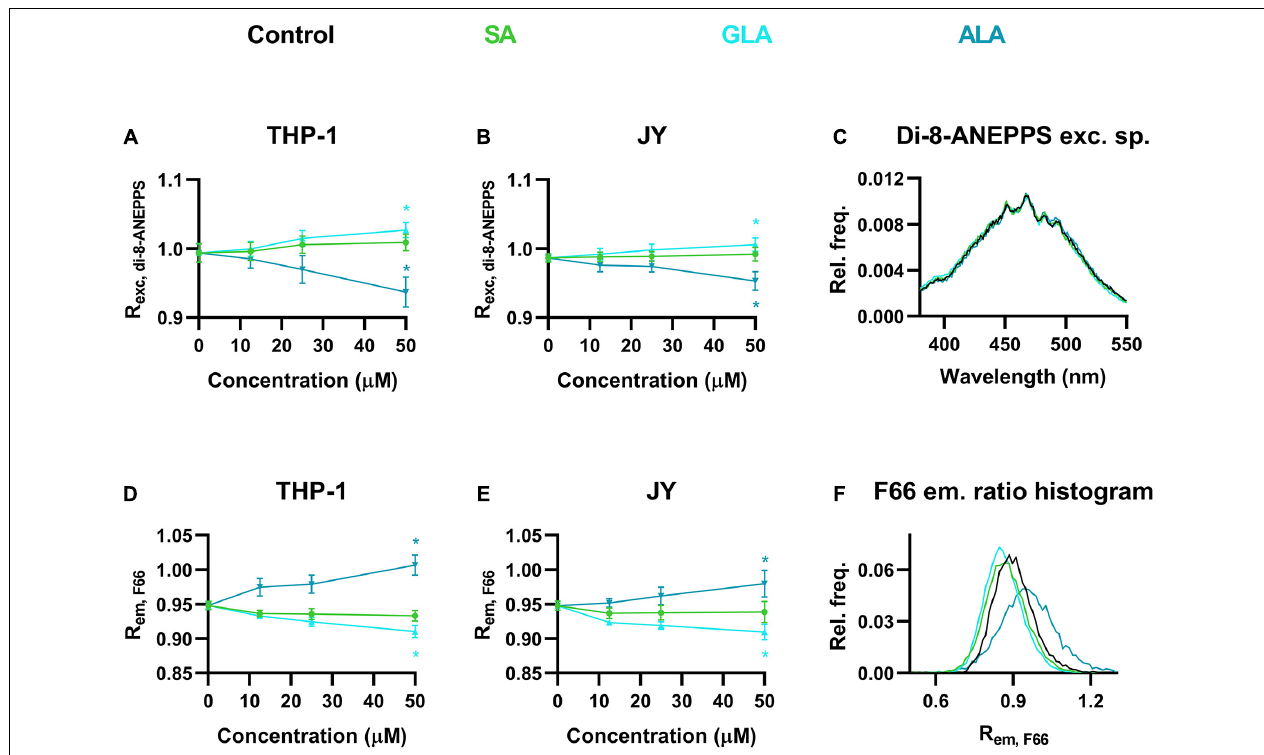
FIGURE 3 | Effects of α -linolenic acid (ALA), γ -linolenic acid (GLA) and stearic acid (SA) on the magnitude of dipole potential. THP-1 (A) or JY cells (B) were treated with ω -3 ALA, ω -6 GLA or fully saturated SA at various concentrations ranging from 12.5 to 50 µ M and labeled with di-8-ANEPPS, which was followed by determination of the dipole potential-sensitive excitation ratio (R exc , di − 8 − ANEPPS ) using spectrofluorometry. R exc , di − 8 − ANEPPS values were calculated from fluorescence intensities integrated between excitation wavelengths 410–440 nm and 490–520 nm and the mean ( ± SD) values of five independent experiments were plotted as a function of the applied concentrations of ALA (blue), GLA (cyan) and SA (green). Representative excitation spectra display shifts induced by the various fatty acids compared to controls (black) (C) . Alternatively, control THP-1 (D) or JY (E) cells and those treated with ALA, GLA or SA were labeled with F66 and the emitted fluorescence intensities of individual cells were measured in the wavelength ranges 470–490 nm and 564–606 nm and the mean intensity ratio (R em , F 66 ) was calculated from data of at least 20,000 living cells per sample. The average values of five independent measurements ( ± SD) were plotted as a function of the applied concentrations of ALA, GLA, and SA. Representative histograms containing data of individual cells display the shifts in R em , F 66 values in response to the different fatty acids compared to controls (F) . Asterisks (*) indicate significant differences obtained at maximal treatment concentrations compared to control samples ( p < 0.05, ANOVA followed by Tukey’s HSD